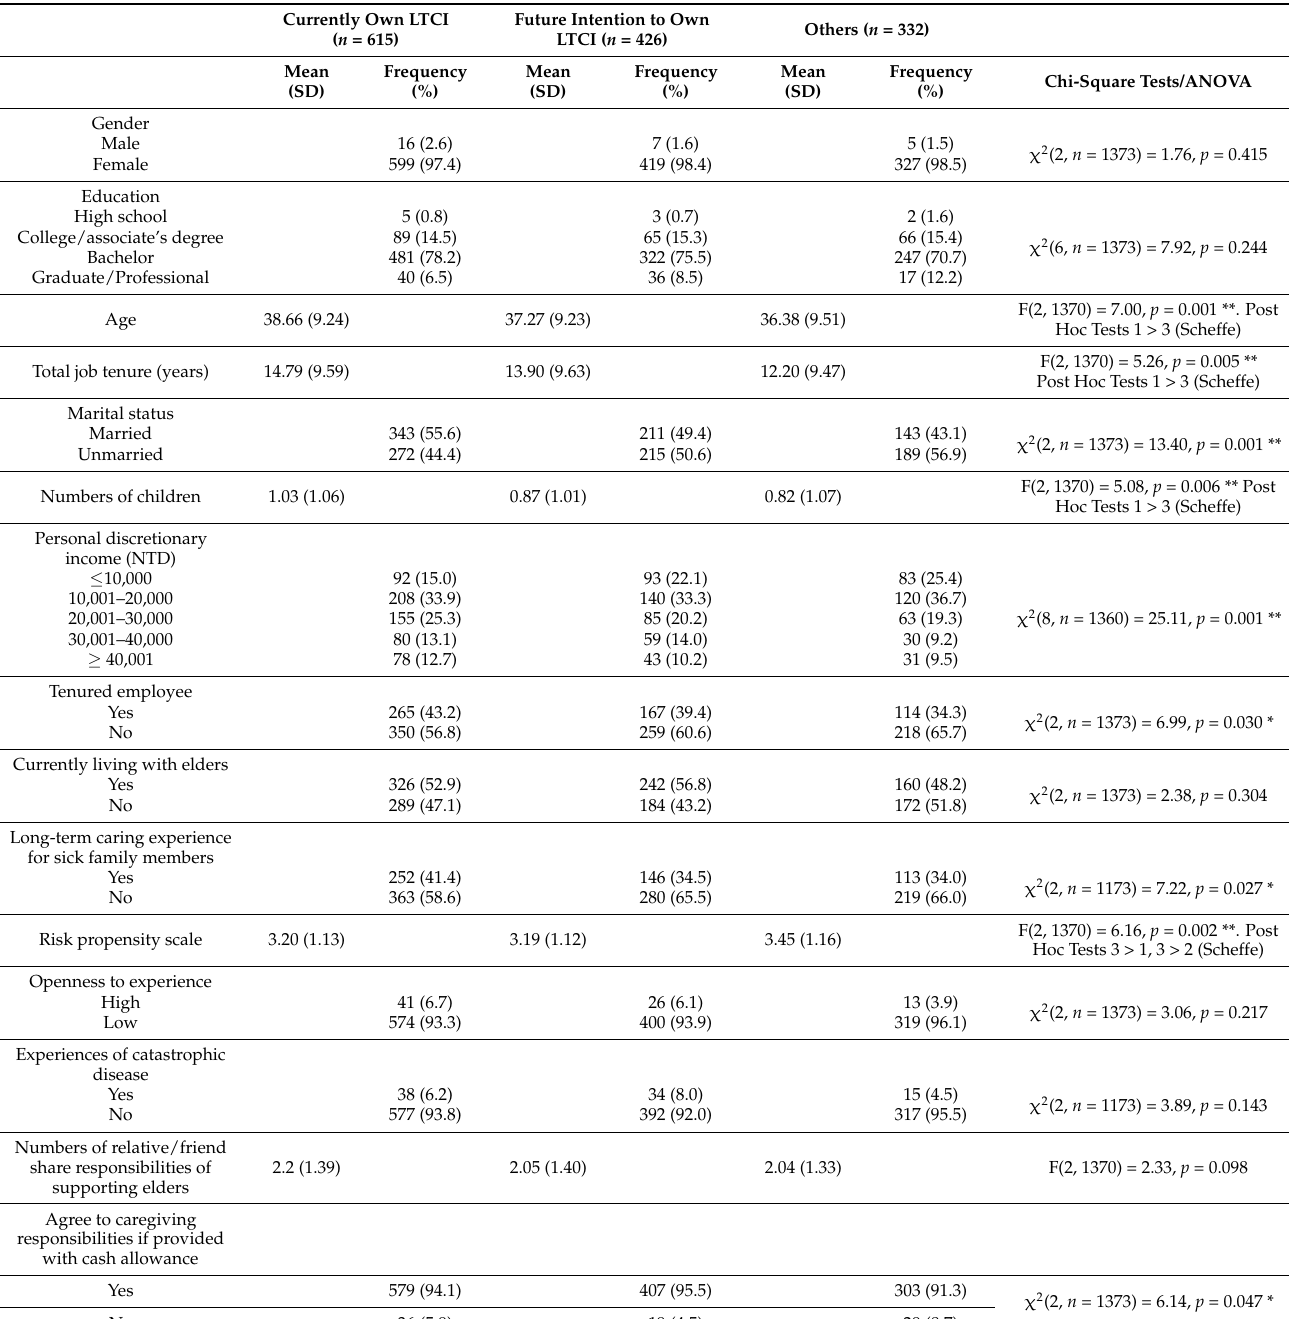
Table 2. Comparison of three groups in characteristics of